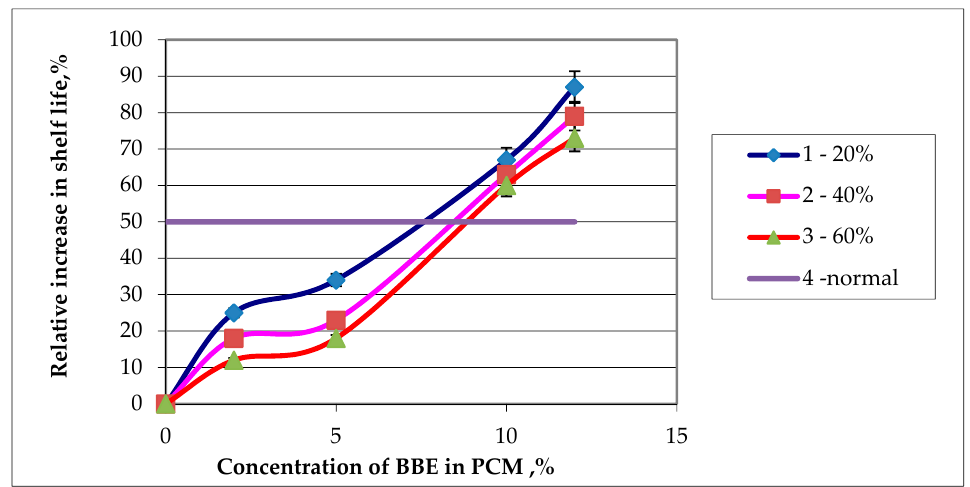
Figure 10. Dependence of the relative increase in shelf life of the food product on the contents of birch bark extract (BBE) in composition material (PCM): (1—content of thermoplastic starch 20% in PCM; 2—content of thermoplastic starch 30% in PCM; 3—content of thermoplastic starch 60% in PCM; 4—desired value to increase product storage).